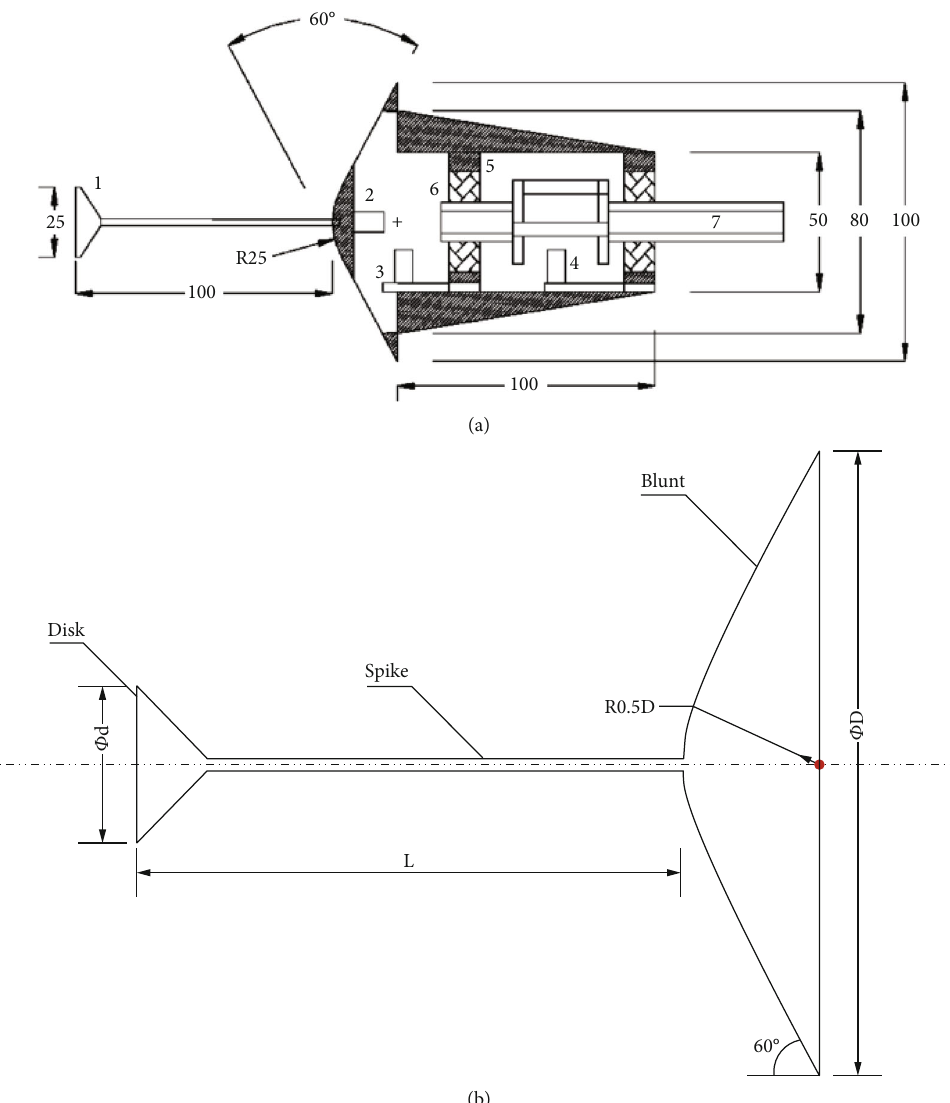
Figure 1: Experimental and numerical models of the aircraft with aerospike. (a) Experimental model. (b) Numerical simulation